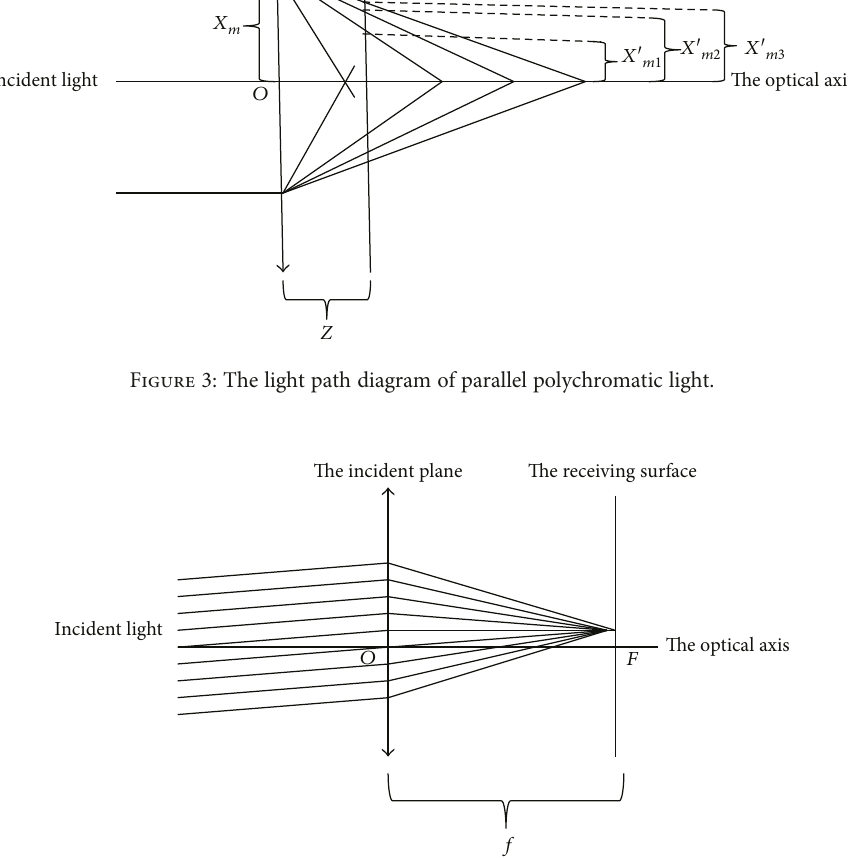
Figure 4: Schematic diagram of a nonparallel monochromatic incident light focusing through a